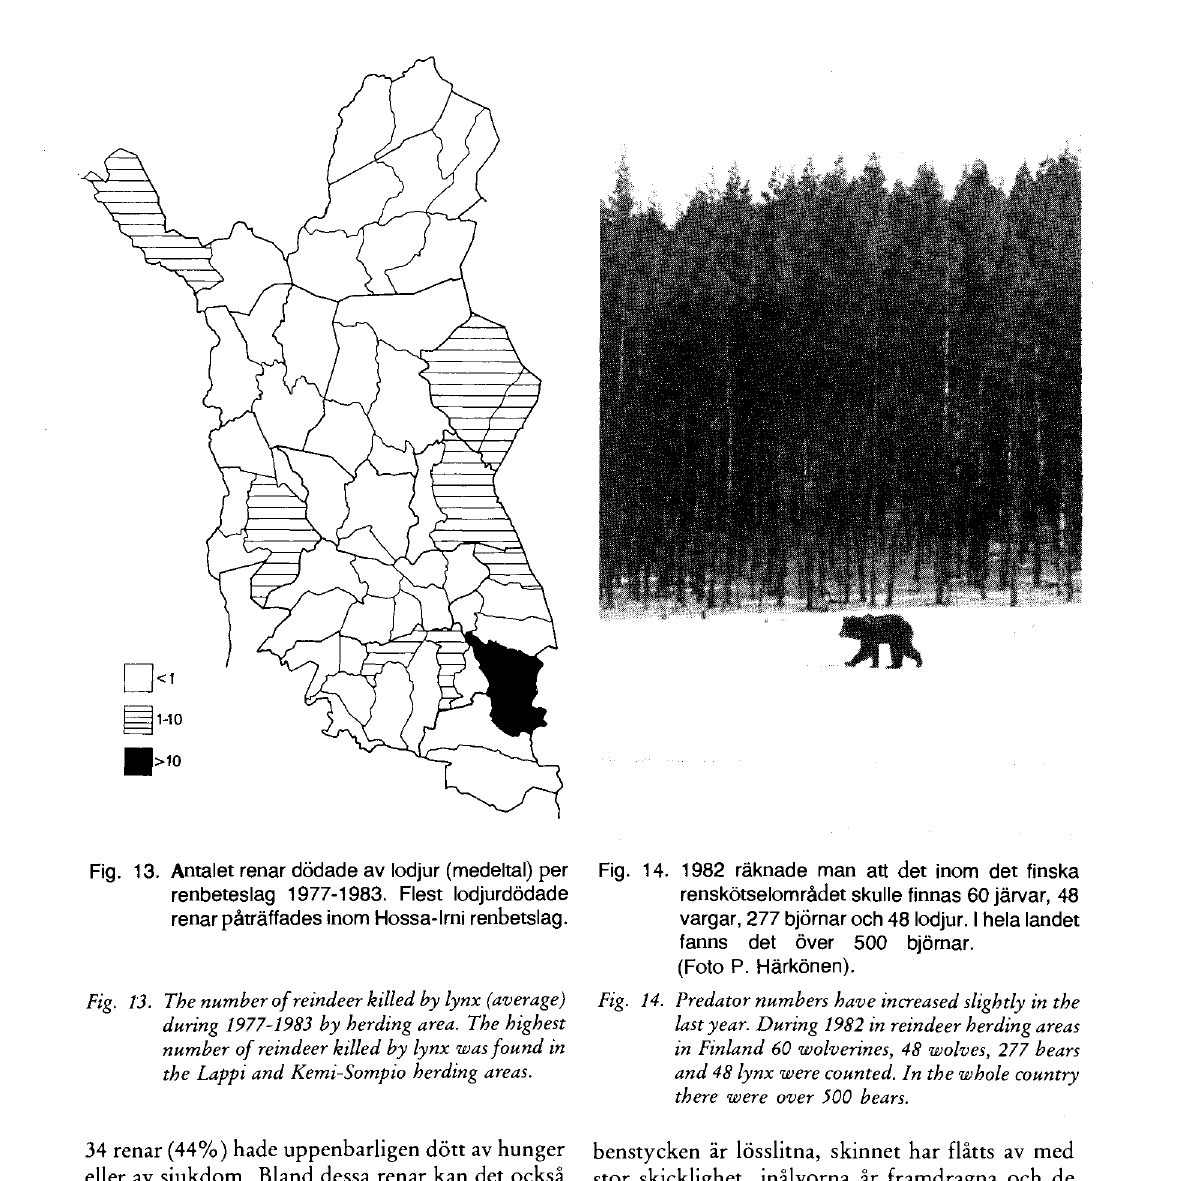
Fig. 14. 1982 räknade man att det inom det finska renskotselområdet skulle finnas 60 jarvar, 48 vargar, 277 björnar och 48 lodjur. I hela landet fanns det över 500 björnar. (Foto P. Härkönen). Fig. 14. Predator numbers have increased slightly in the last year. During 1982 in reindeer herding areas in Finland 60 wolverines, 48 wolves, 277 bears and 48 lynx were counted. In the whole country there were over 500